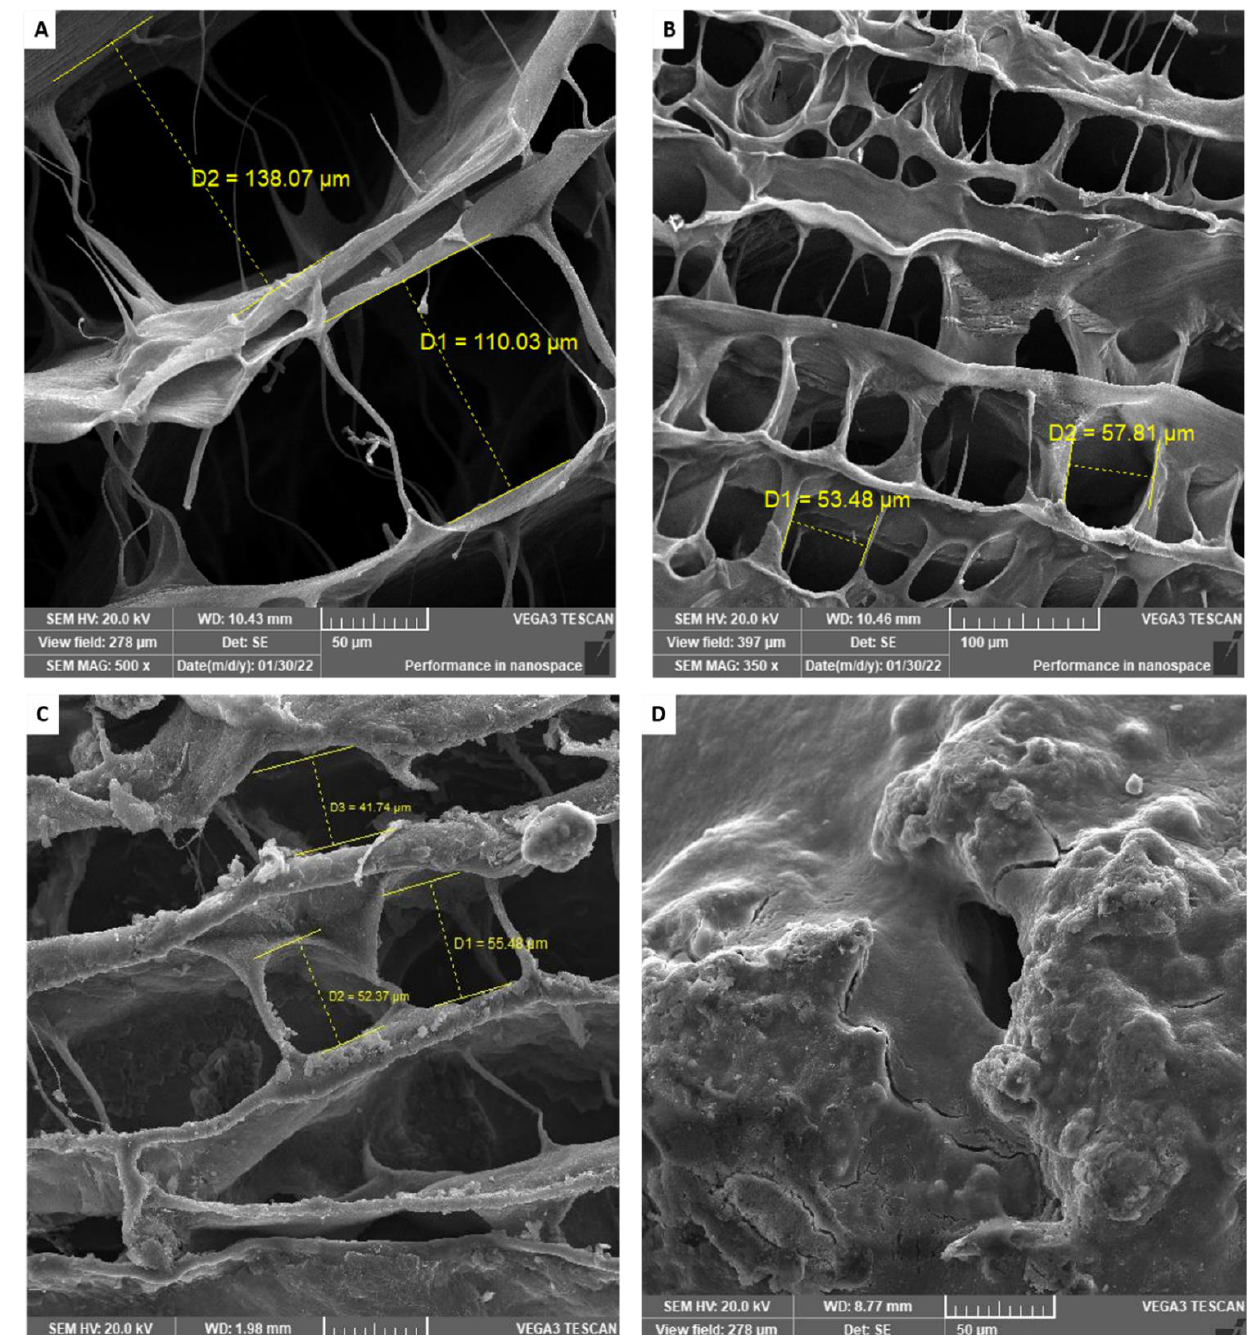
Figure 3. Scanning electron microscope images of ( A ) plain alginate aerogel; ( B ) plain alginate/nano- hydroxyapatite aerogel (A 3 H 1 N); ( C ) alginate/nano-hydroxyapatite aerogel loaded with tranexamic acid (A 3 H 1 ); ( D ) A 3 H 1 hydrogel after drying.